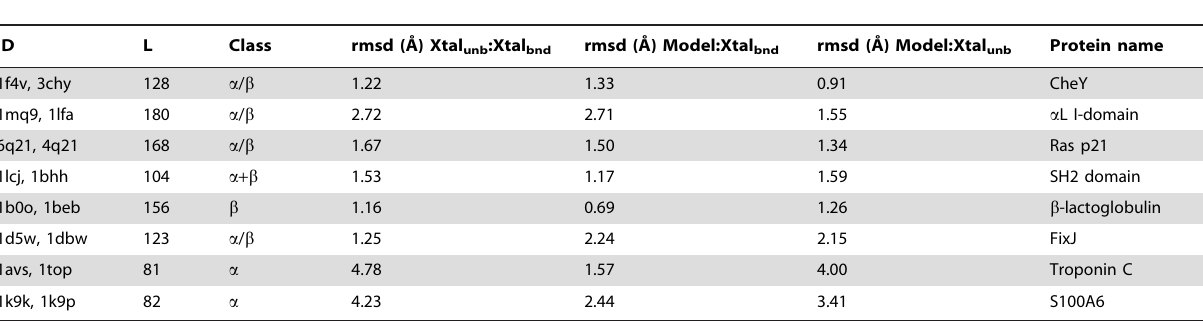
Table 1. Test set for predicting conformational change from bound to unbound